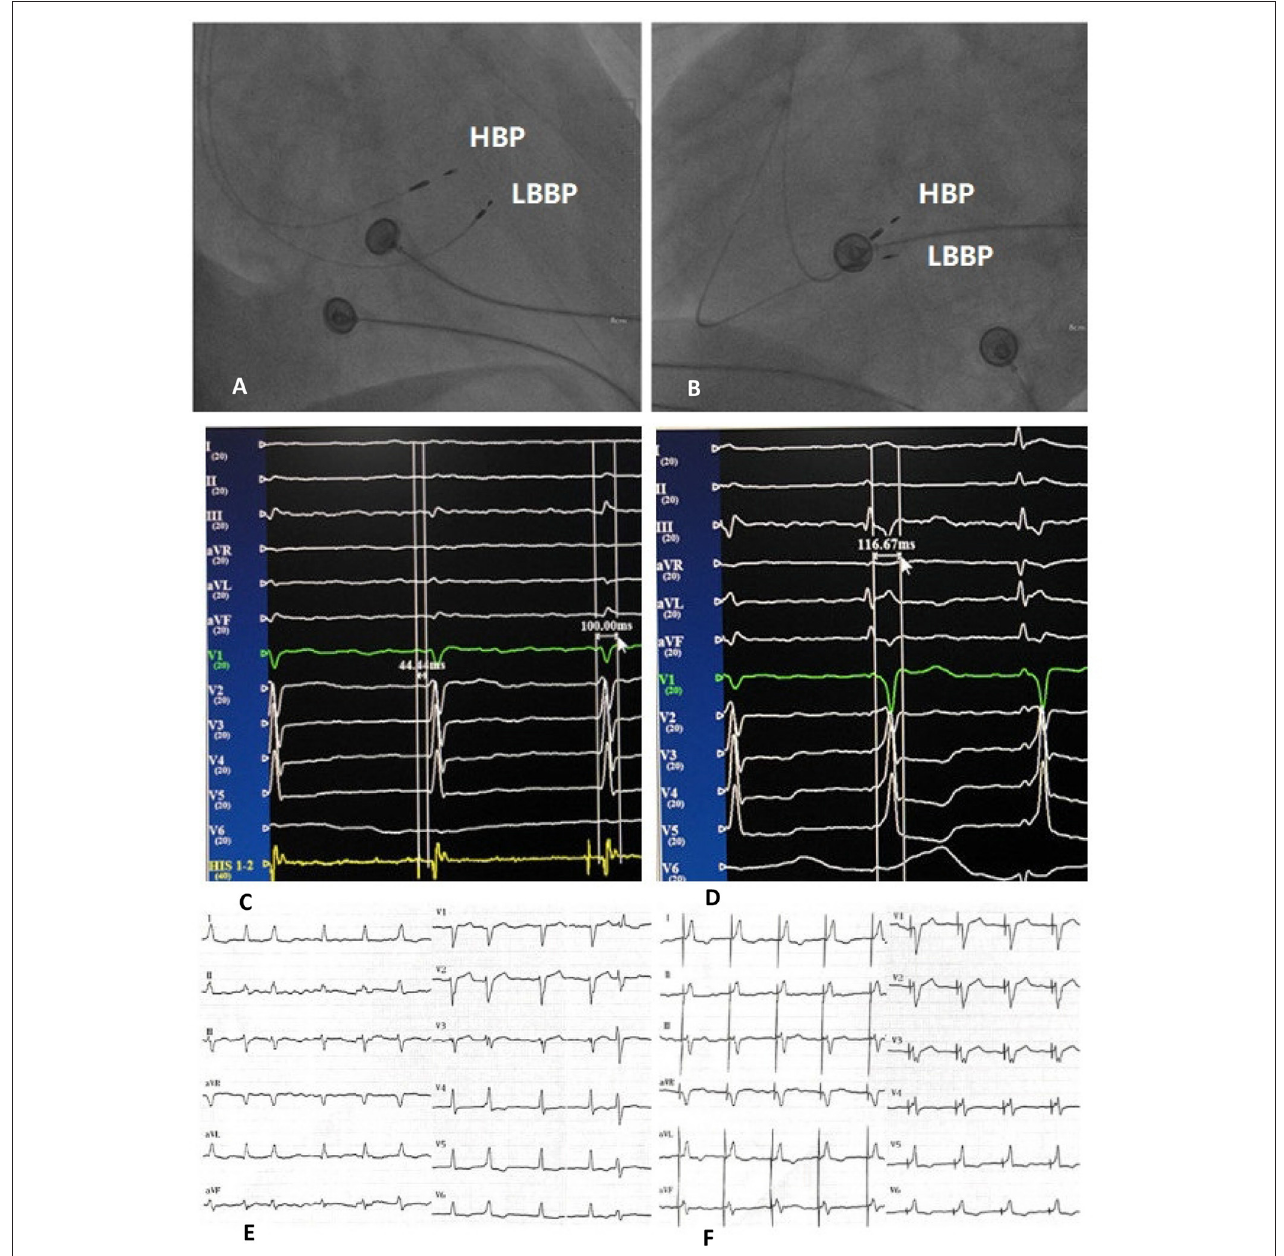
FIGURE 1 | Right anterior oblique fluoroscopic projections showing location of HBP lead and LBBP lead (A) . Left anterior oblique fluoroscopic projections showing location of HBP lead and LBBP lead (B) . Twelve-lead ECG and EGM from HBP leads of intrinsic rhythm and HV interval (C) . Twelve-lead ECG and EGM from HBP leads of NS-HBP (D) . Bedside twelve-lead ECG of intrinsic rhythm (E) . Bedside twelve-lead ECG of NS-HBP (F) . HBP, His bundle pacing; LBBP, left bundle branch pacing; ECG, electrocardiogram; EGM, electrogram; HV interval, His-QRS onset interval; NS-HBP, non-selective His bundle pacing.